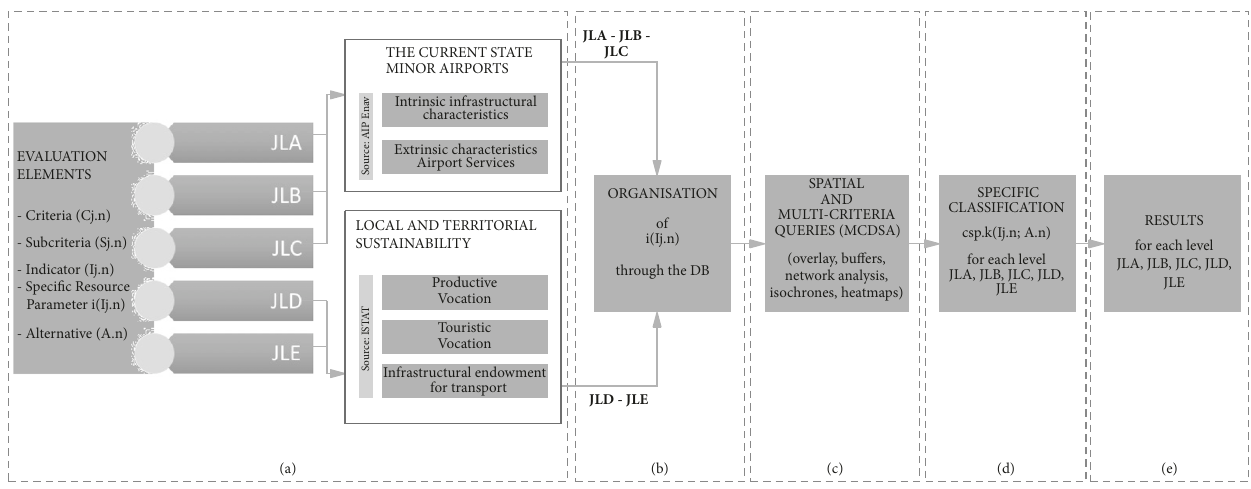
Figure 3: Framework of the